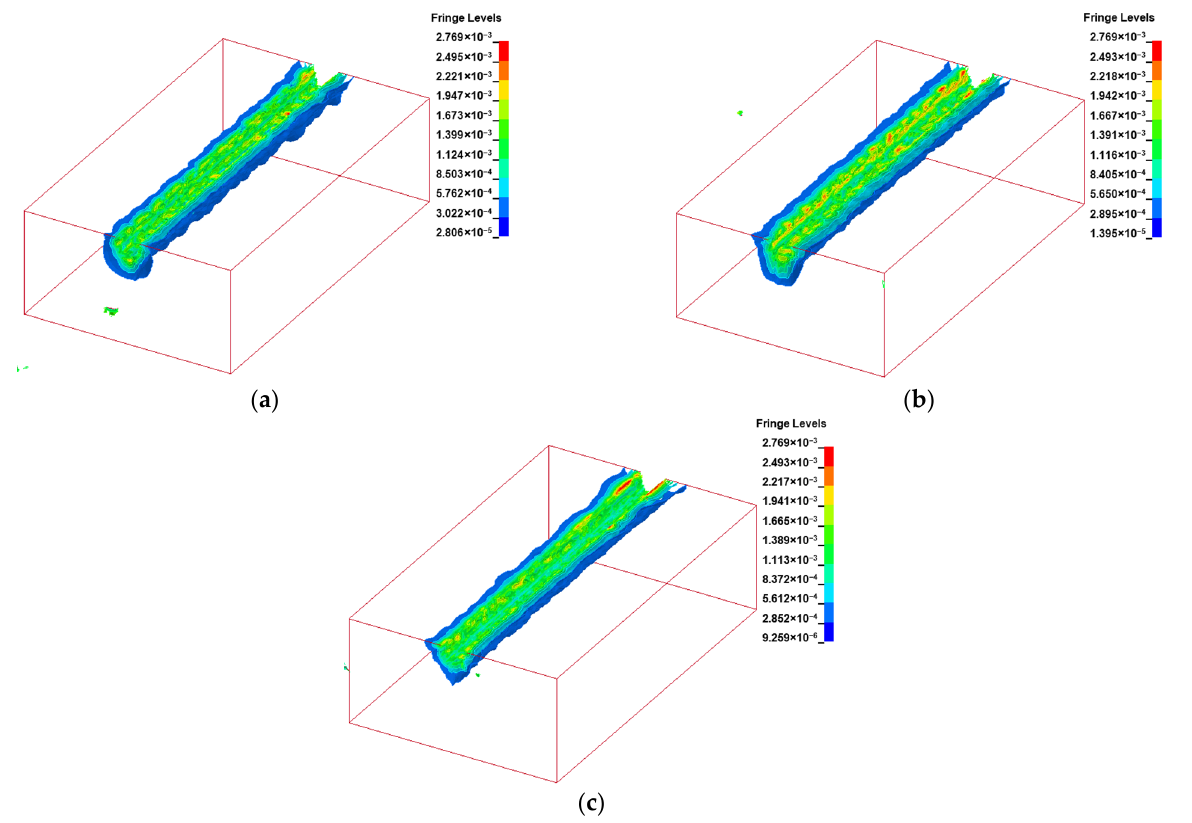
Figure 17. Equivalent stress isosurface of rock breaking using disc cutter with 22 mm blade width. ( a ) Isosurface of equivalent stress (Blade fillet 0 mm); ( b ) Isosurface of equivalent stress (Blade fillet 5 mm); ( c ) Isosurface of equivalent stress (Blade fillet 9 mm).